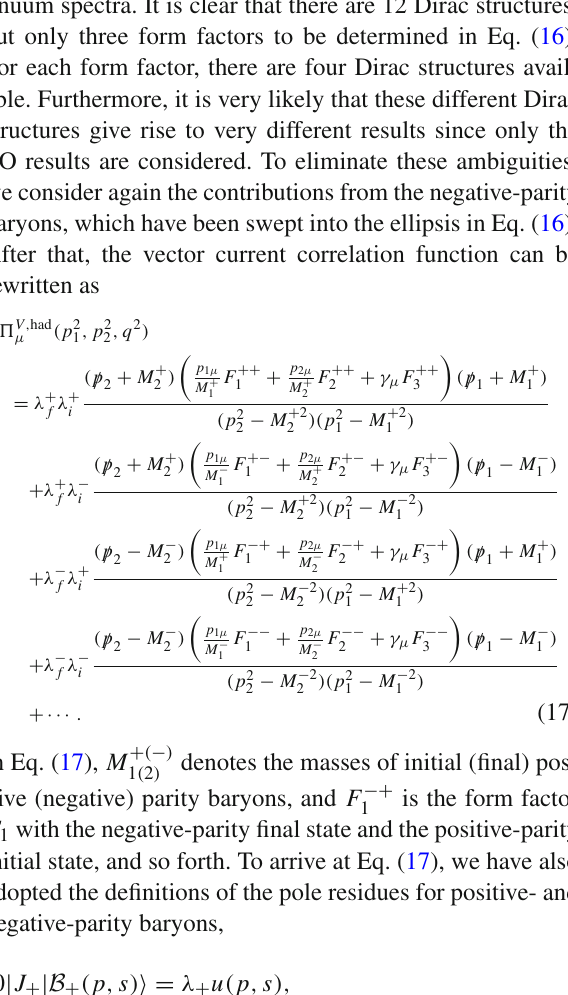
where λ i ( f ) = λ (cid:2) , F i are form factors defined in Eq. (11), b ( c ) M 1 , 2 are the masses of initial and final states and the ellipsis stands for the contribution from higher resonances and con- tinuum spectra. It is clear that there are 12 Dirac structures, but only three form factors to be determined in Eq.